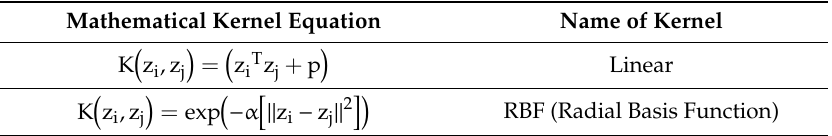
Table 1. Kernel functions.